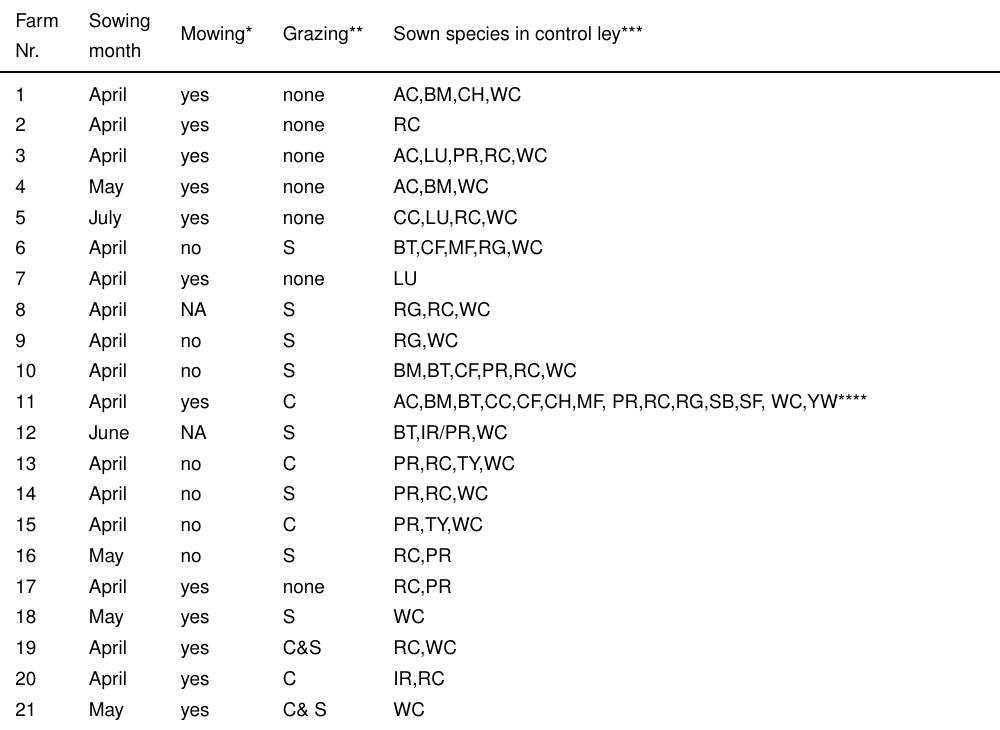
Table 4. Management details for on-farm